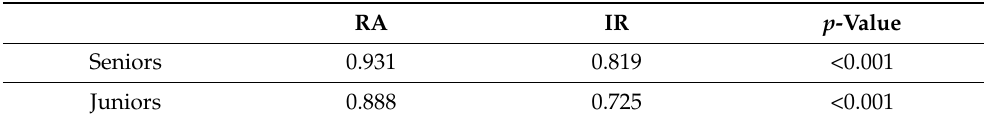
Table 4. Seniors and juniors interclass correlation coefficient (ICC) for raters’ average (RA) and individual raters